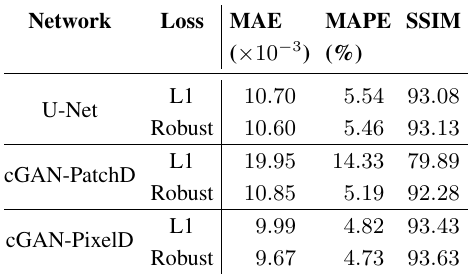
Table 2. The result comparison of different methods. MAE, MAPE and SSIM of generated NIR band is calculated.